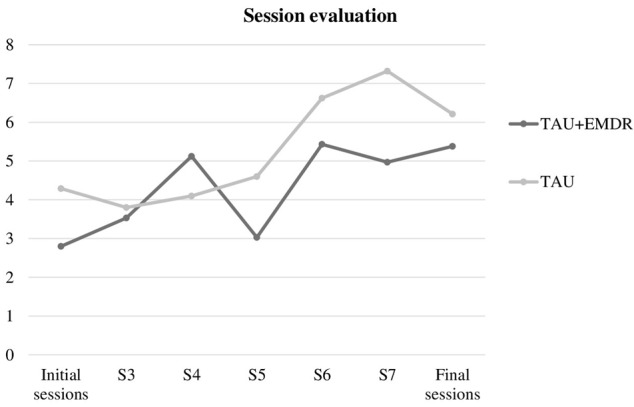
Session evaluation.